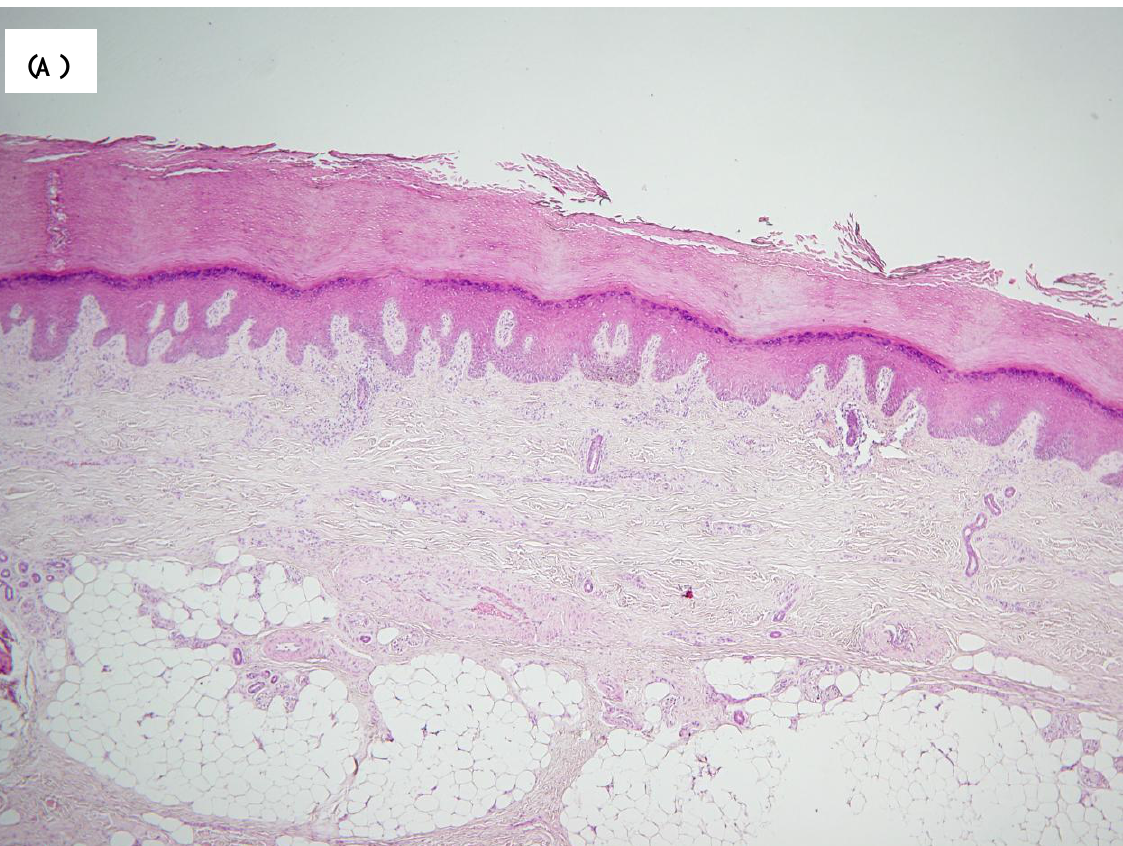
Figure 2. (A) Patient 5: retiform epidermal hyperplasia with somewhat broad rete pegs (H&E, ×40); (B) Patient 5: diffuse lentiginous pattern of melanocytic proliferation along the dermo-epidermal junction with hyperplastic epidermis compatible with ALM in